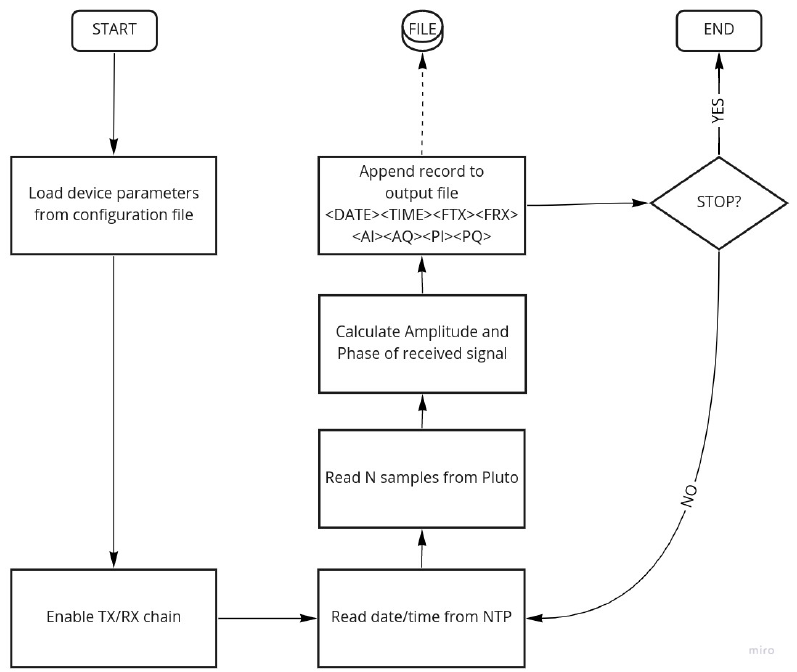
Figure 9. Flow chart of the “plutoScan.sh” software that allows us to control the RADAR for microwave